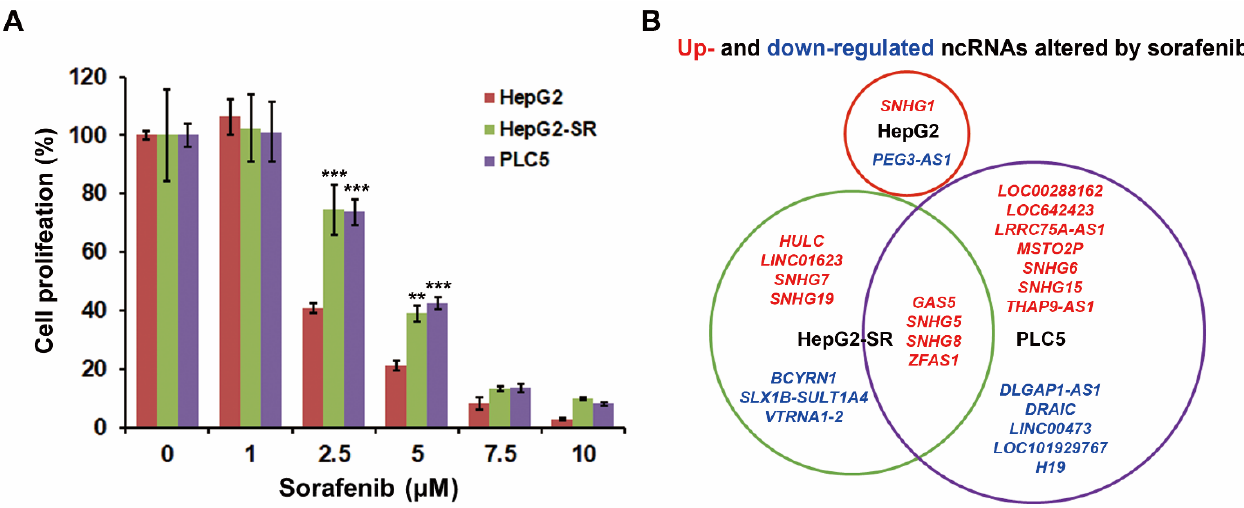
Figure 1. Identification of sorafenib-induced lncRNAs in sorafenib-resistant HCC cells. ( A ) HepG2, HepG2-SR, and PLC5 cells were treated with 0–10 µ M sorafenib for 48 h. The cell proliferation was examined by BrdU incorporation assay. ** p < 0.01 and *** p < 0.001 indicated the statistically significant difference compared to sorafenib-treated HepG2 cells. ( B ) HepG2, HepG2-SR, and PLC5 cells were treated with 5 μM sorafenib for 24 h. Total RNAs were subjected to RNA-sequencing. The altered lncRNAs were shown as a Venn diagram. Genes in red or blue indicated that they were upregulated or downregulated by sorafenib, respectively.